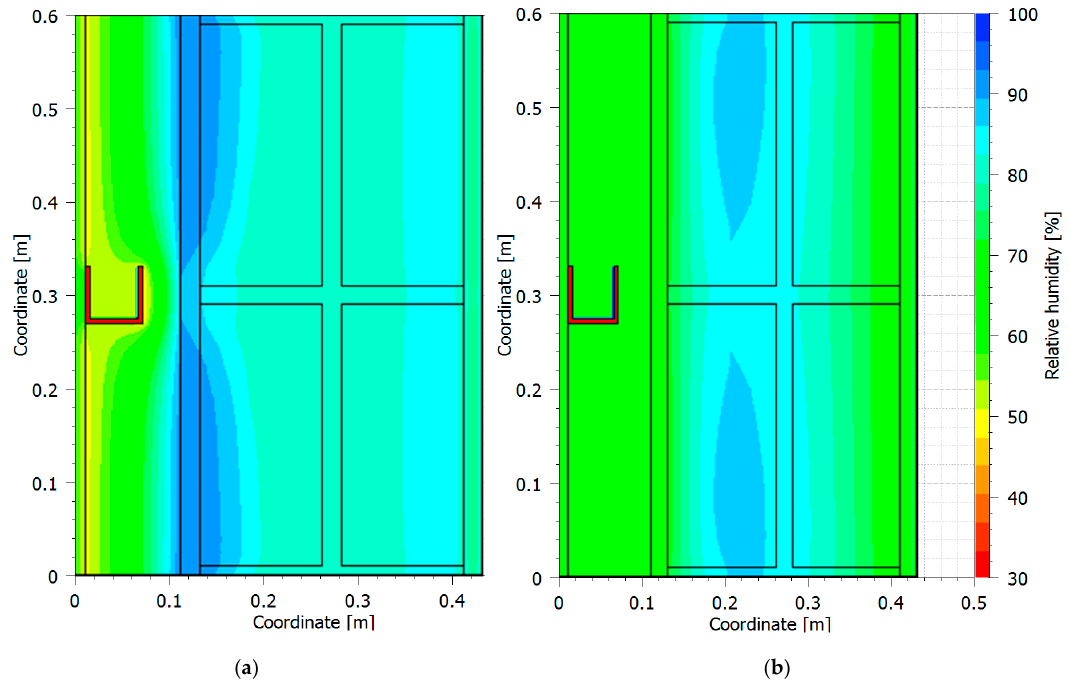
Figure 14. RH profile of the original simulated wall during the most critical ( a ) and the most favourable ( b ) hours of the year.